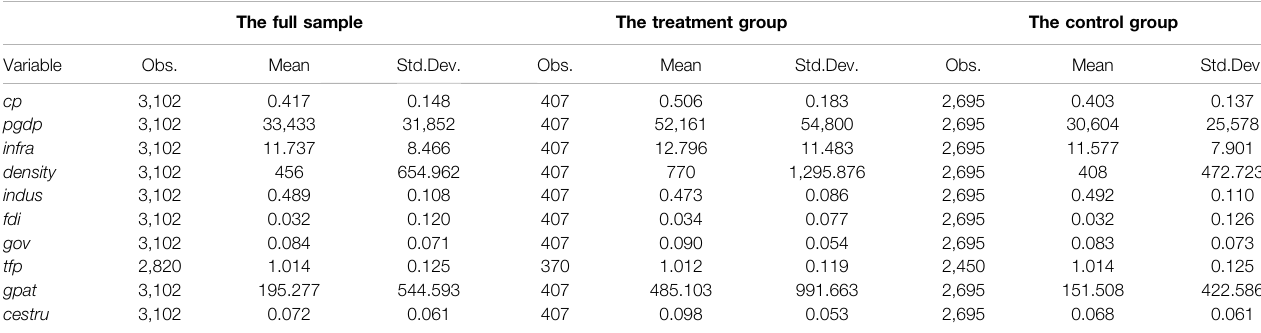
TABLE 2 | Descriptive statistics of